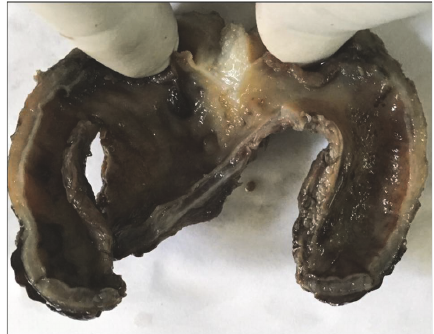
Figure 3: Specimen comprising of a unilocular mass with thickened wall and inner surface markedly congested.